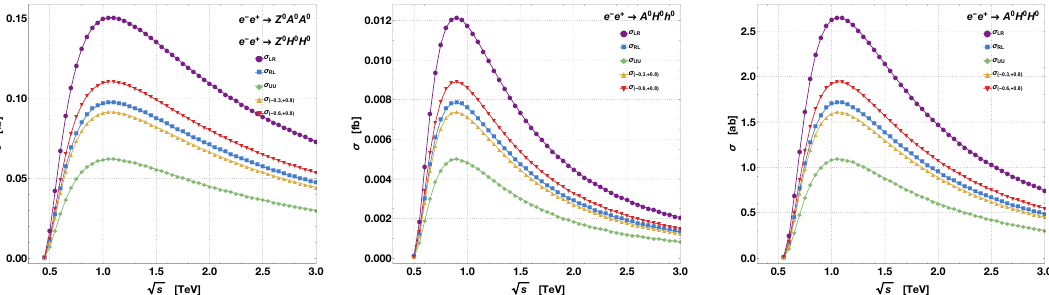
Figure 5 . The distributions of the cross section for various polarizations of the incoming e (cid:0) e + beams. The mass of the extra Higgs states is set as m H = 175 GeV, and t (cid:12) = 10 is assumed. (Left): the cross section distributions for e (cid:0) e + ! Z 0 A 0 A 0 and e (cid:0) e + ! Z 0 H 0 H 0 are given. (Center): the distributions are for e (cid:0) e + ! A 0 H 0 h 0 . (Right): the process e (cid:0) e + ! A 0 H 0 H 0 is